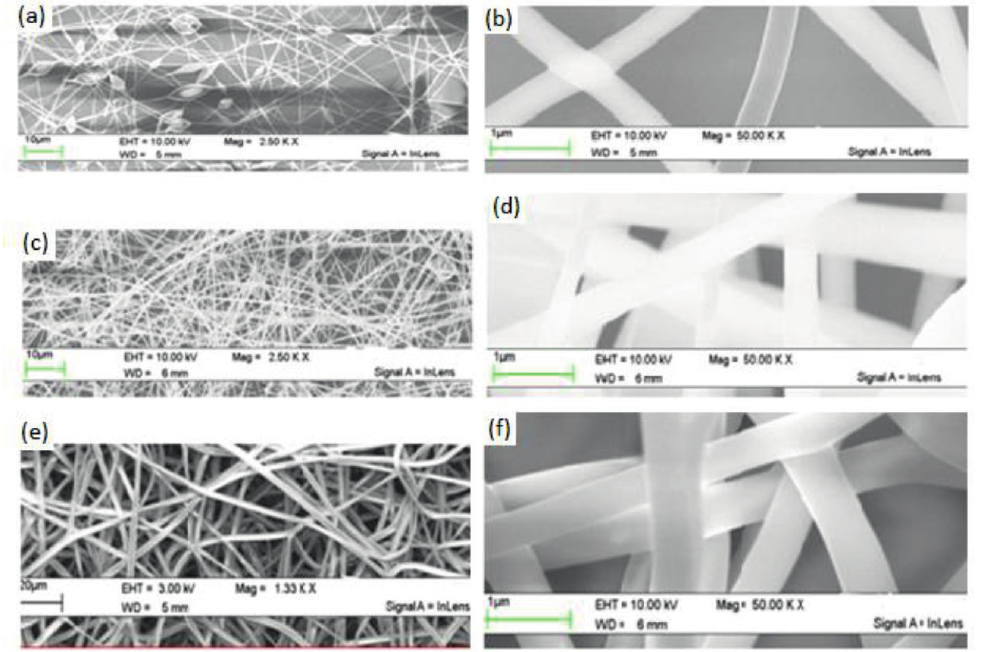
), c) Low 2 ) f) High Magnification 2